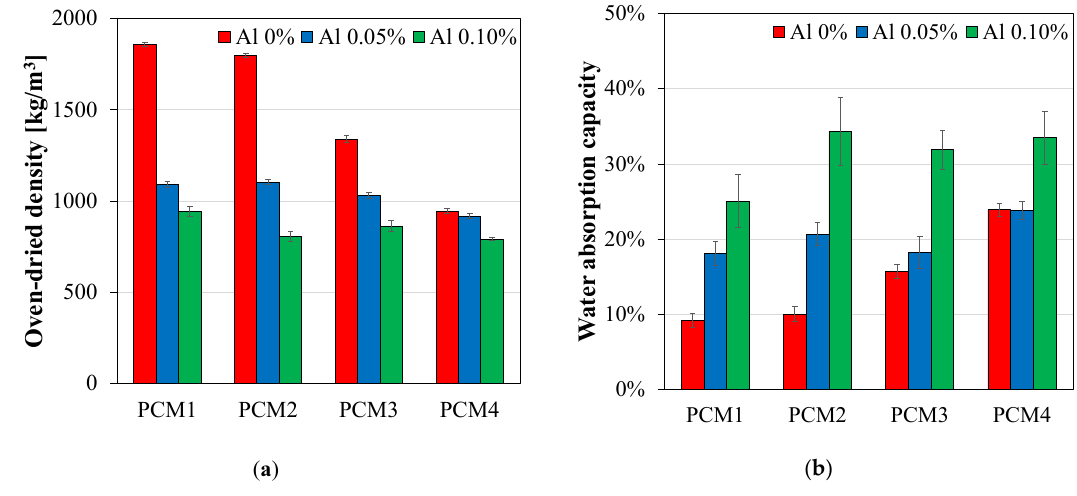
Figure 3. ( a ) Oven-dried density and ( b ) water absorption capacity of the tested porous cementitious materials.